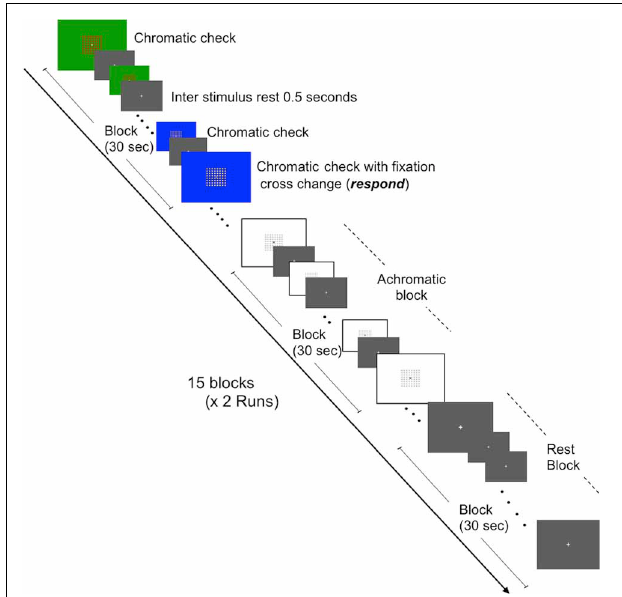
FIGURE 2 | Schematic of fMRI task for brain activation in response to meaningful letters and non-meaningful characters. Representations of the three conditions (letters, non-meaningful characters, and rest states) are depicted. Two runs (7min and 30s each) containing 15 blocks (30s in duration) and consisting of equal amounts of each condition, i.e., five blocks of each condition per run were